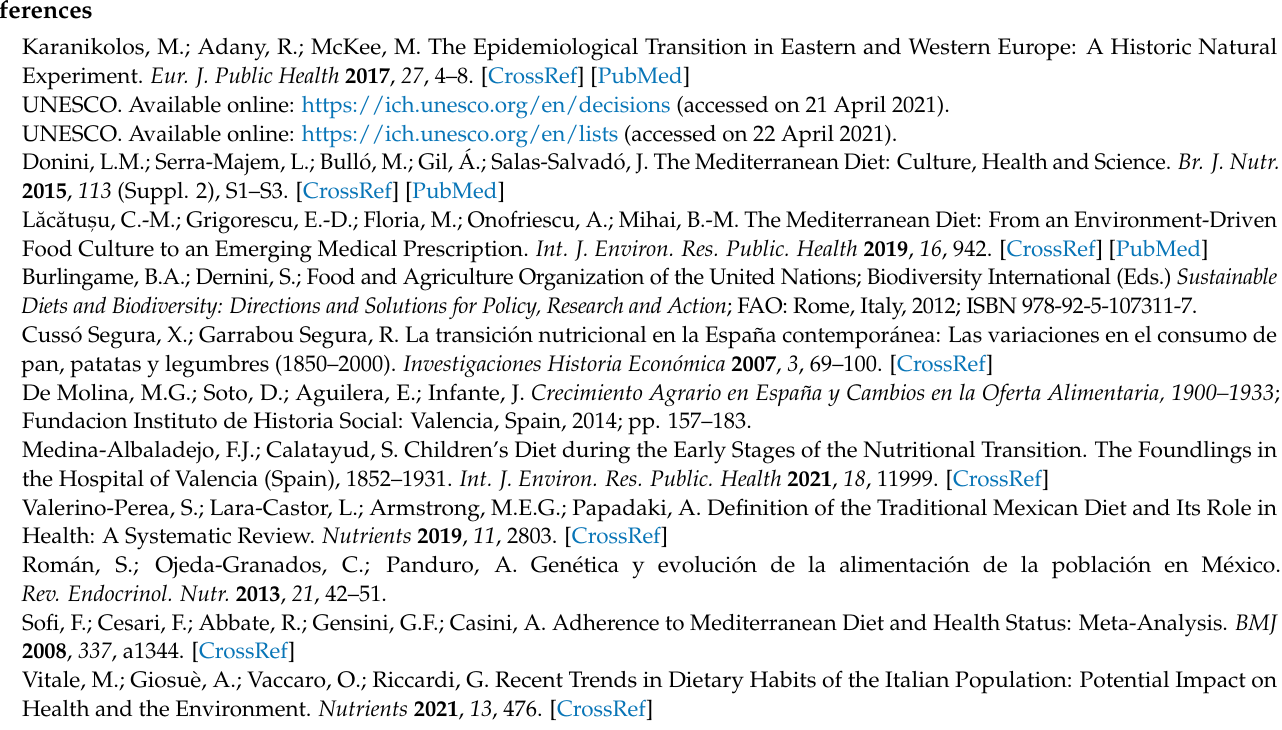
questionnaire data; Table S2: Factor loading matrix of main dietary patterns identified in Italian women; Table S3: Factor loading matrix of main dietary patterns identified in Mexican